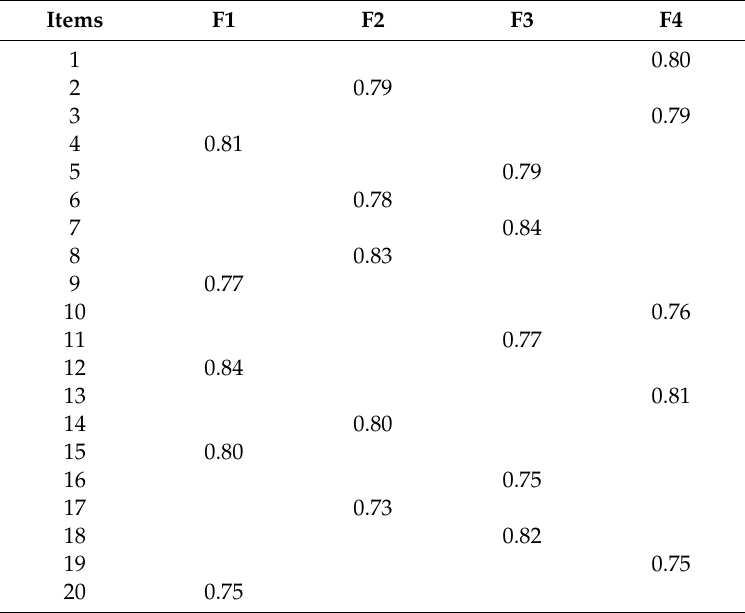
Table 1. Distribution of measurement